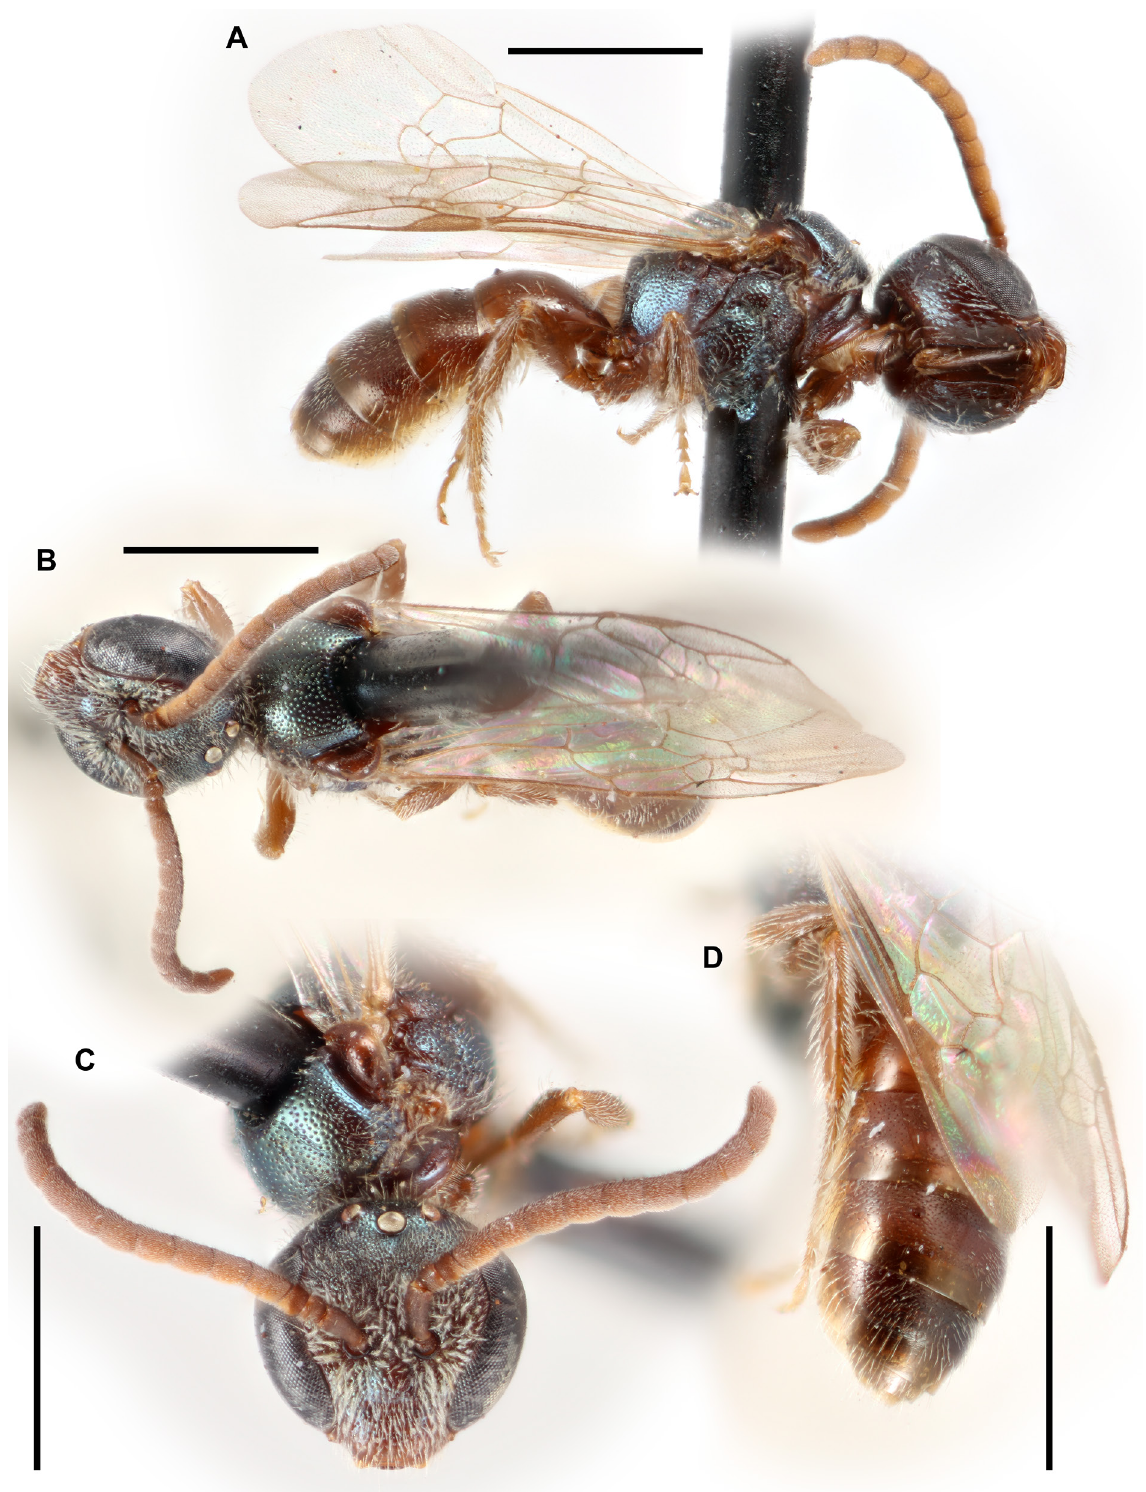
Fig. 7. Lasioglossum ( D .) carlinvillense Gibbs, 2009, possible ♂ (based on a single male associated with a single female) (BBSL700633). A . Lateral habitus. B . Dorsal habitus. C . Face. D . Metasoma. Scale bars = 1